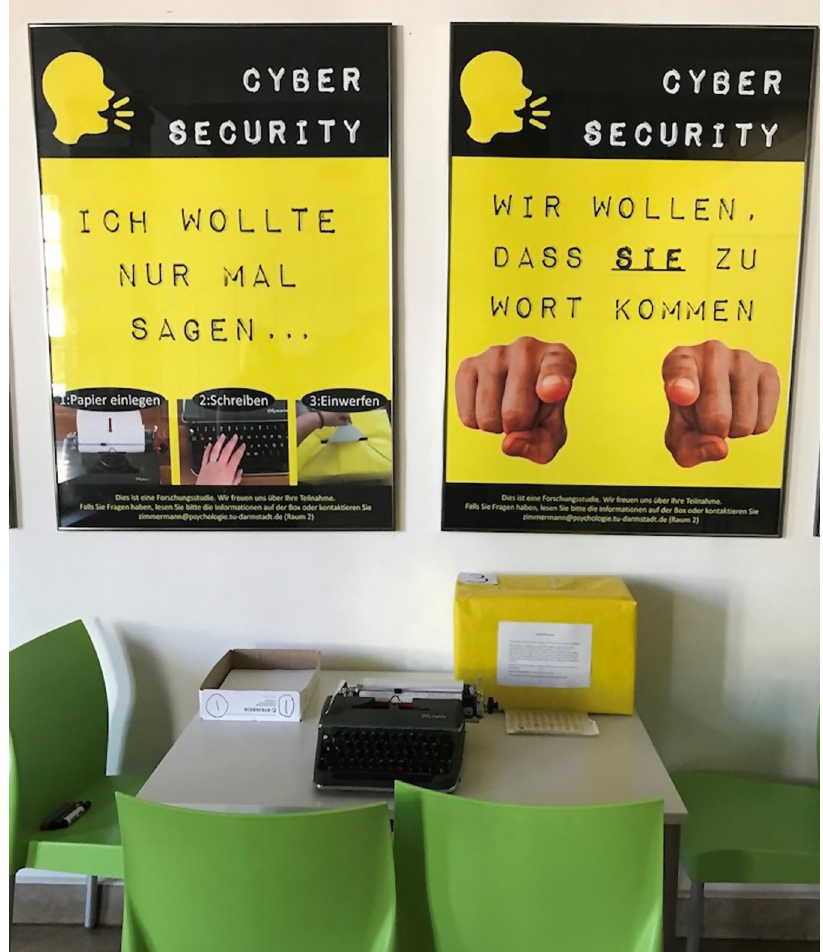
Fig. 5 The pilot study setup with the typewriter, posters and yellow box for people to submit their typewritten